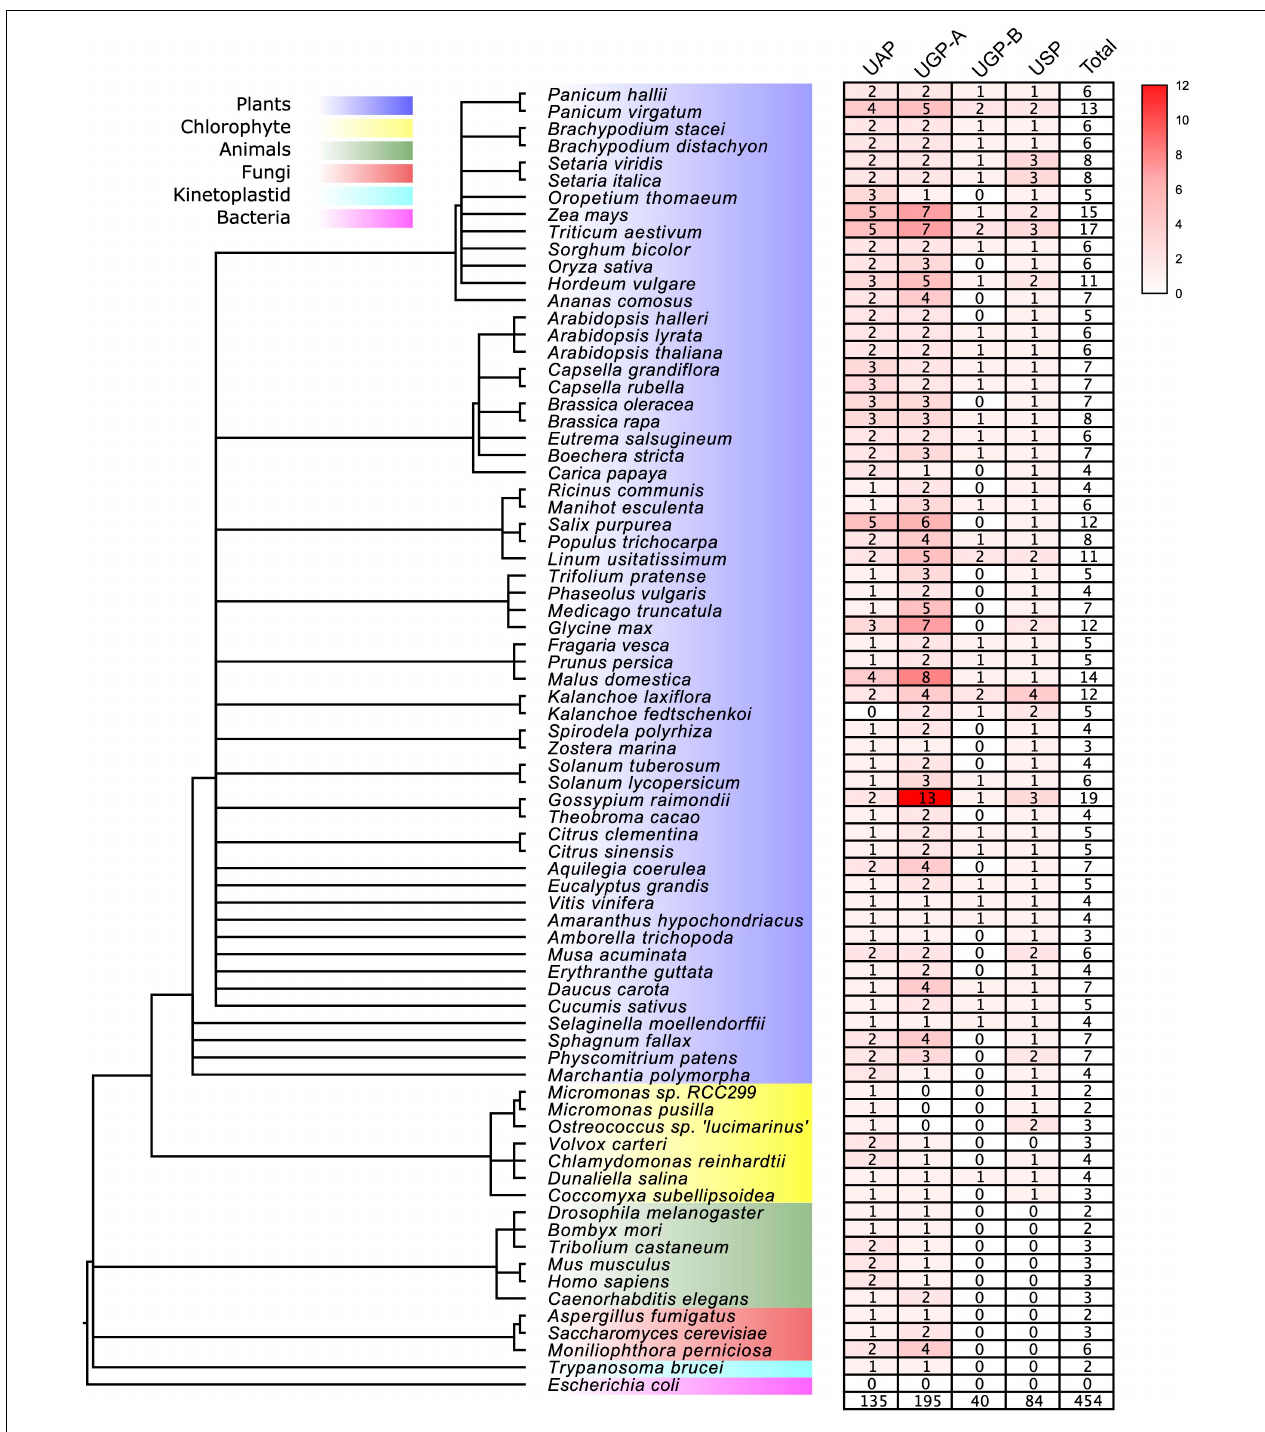
FIGURE 1 | The UDP glucose pyrophosphorylase (UDPGP) genes were investigated in this study. The species tree was downloaded from the National Center for Biotechnology Information (NCBI) Taxonomy tree.